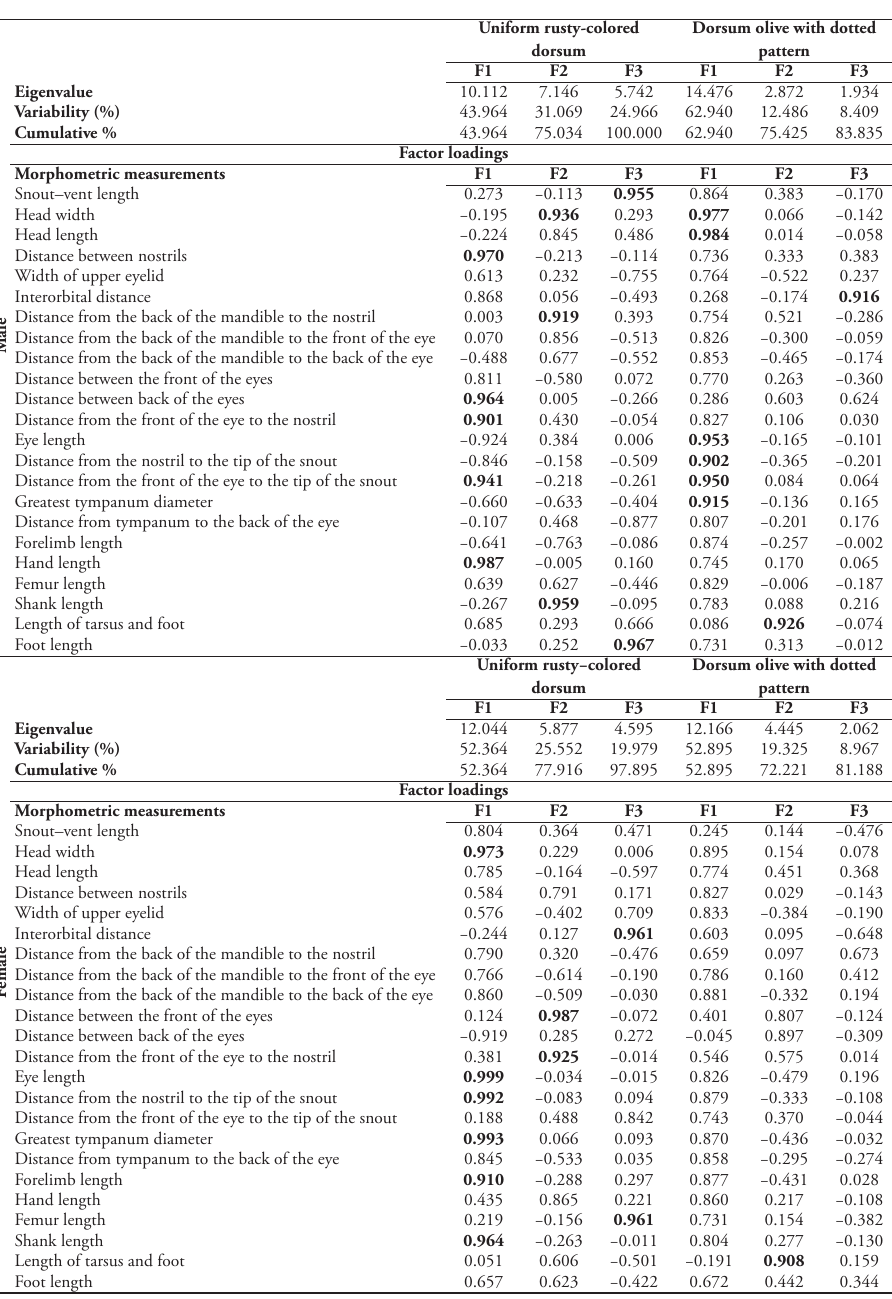
Table 1. Eigen value, variability (%), cumulative variability (%) and factor loadings of the 23 morphometric measurements of the two forms (uniform rusty-colored dorsum and dorsum olive with dotted pattern) of Sphaerotheca maskeyi. The factor loadings with absolute correlation values greater than 0.90 were considered significant (in